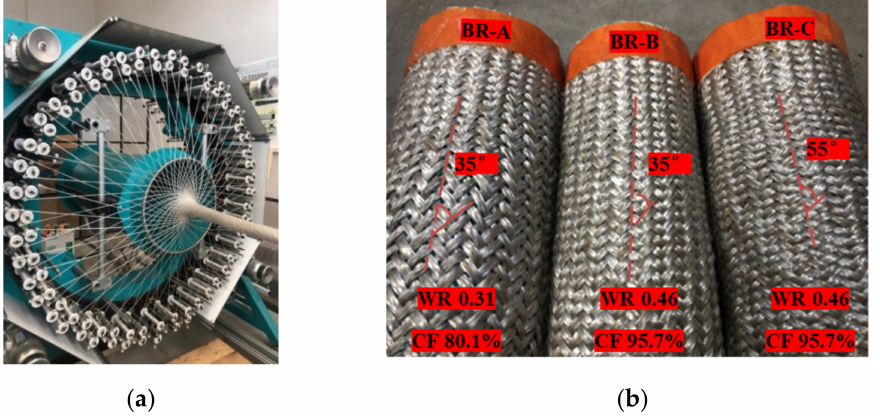
Figure 6. 2D biaxial braided preform: ( a ) braiding loom, ( b ) obtained different 2D biaxial braids tubes. After braiding, the different circular braided preform were opened and cut in AD and TD to obtain the one-layer braided specimens (with surface dimension 70 × 200 mm 2 , for which r = 2.86 respecting the restrictive condition developed as Equation (3)). The main properties of these six different braided specimens, illustrated in Figure 7, are listed in Table 1. Unit cell geometries were measured by Image J software; thickness was evaluated according to the ISO 5084 standard [53]; tow waviness ratio and cover factor were calculated by Equations (1) and (2); areal density according to the ISO 12127 standard [54]; and air permeability according to the ISO 9237 standard